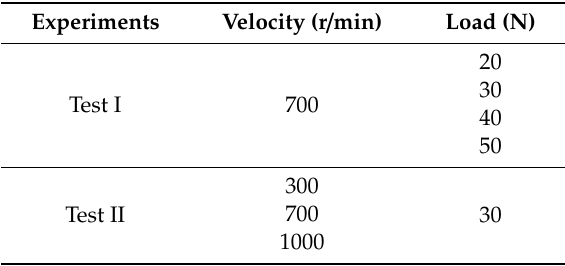
Table 1. Experimental parameters for Test I and